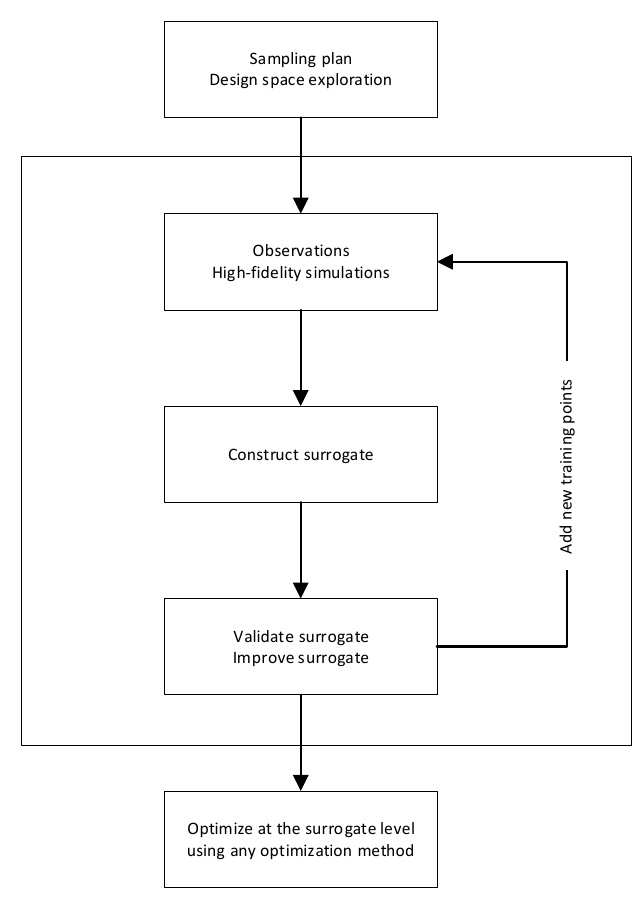
Figure 3. Surrogate-based optimization